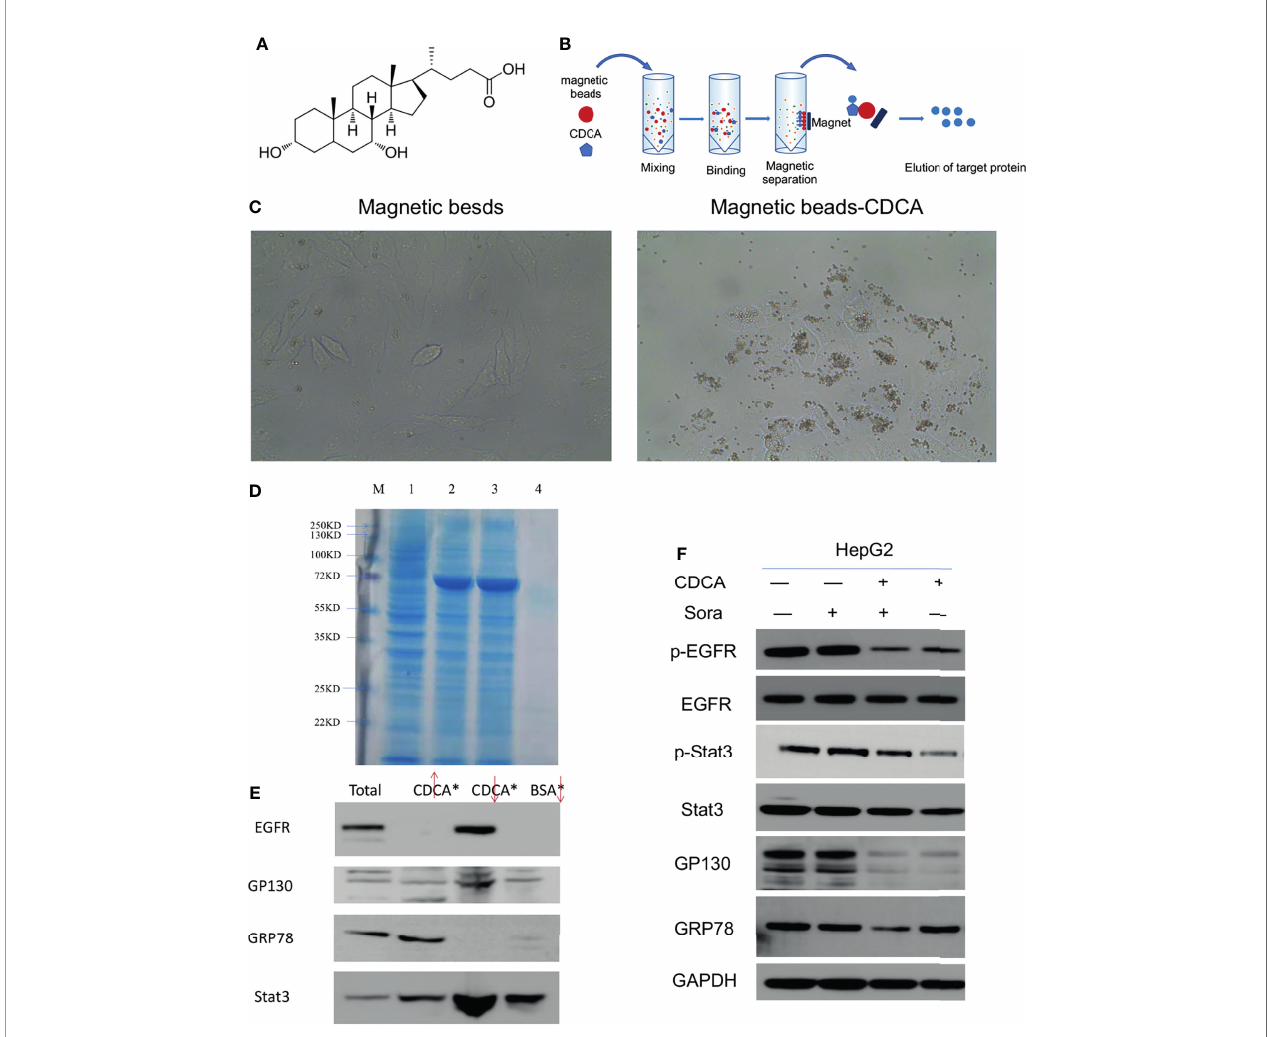
FIGURE 3 | Targeting of CDCA to HepG2 cells. Using magnetic beads-CDCA coupling, total binding proteins were obtained by precipitation, and binding proteins were identi fi ed by mass spectrometry analysis. (A) Chemical structure of CDCA. (B) Schematic diagram of CDCA coupling to magnetic beads. (C) Light micrograph of CDCA magnetic beads coupled to HepG2 cells after co-culture (40x). (D) Kaomas brilliant blue staining of binding protein, M is Marker,1 is total protein,2 is CDCA magnetic bead isolate protein 1,3 is CDCA magnetic bead isolate protein 2,4 is BSA bead isolated protein. (E) Western blot detection of EGFR, GP130, GRP78 and Stat3 protein expression by magnetic bead-immunoprecipitation assays (From left to right, total protein, magnetic bead supernatant, magnetic bead precipitate, BSA control). (F) The cellular experiments in Figure 1 were repeated to con fi rm the changes in protein levels after drug